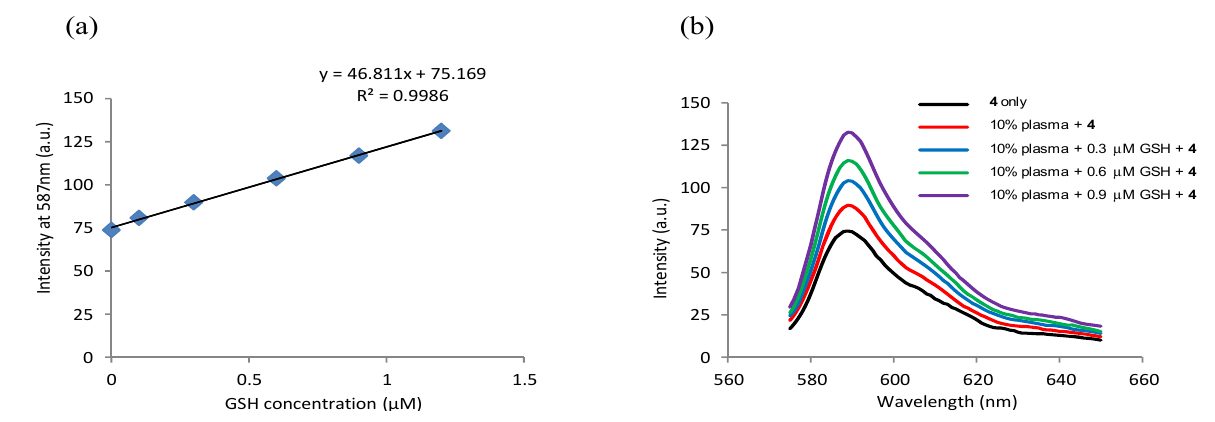
Figure 7. Determination of GSH in human plasma using the 4- CTAB system. ( a ) Calibration curve of 4 (1.0 µM) in 2.0 mM CTAB media buffered at pH 6 (phosphate buffer, 50 mM) showing a linear relationship between fluorescence intensity ( λ λ = 587 nm) and GSH concentration (0.1–1.2 µM); ( b ) Fluorescence spectra ( λ em of 4 (1.0 μ M) upon addition of GSH (0–1.0 μ M) to 10% deproteinized plasma diluted with 2.0 mM CTAB media buffered at pH 6.0 (phosphate buffer, 50 mM). The calibration curve and emission spectra were collected 8 min after mixing.